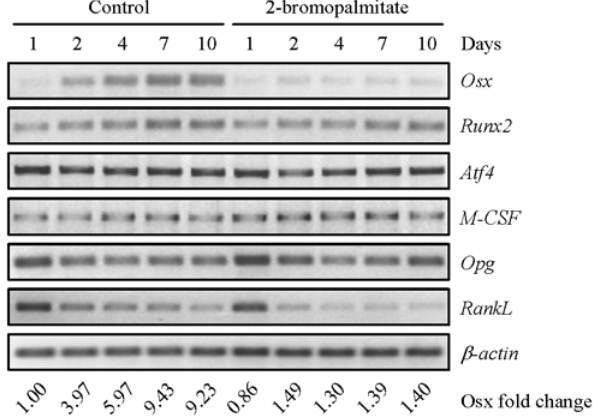
Figure 4. Regulation of Osx by 2BP. Primary osteoblasts were cultured in differentiation medium with or without 100 m M of 2BP for different periods of time. These cells were then collected to isolate total RNA. RT-PCR was carried out to determine the mRNA levels of these proteins. The value of control (lane 1) was set at 1.00.